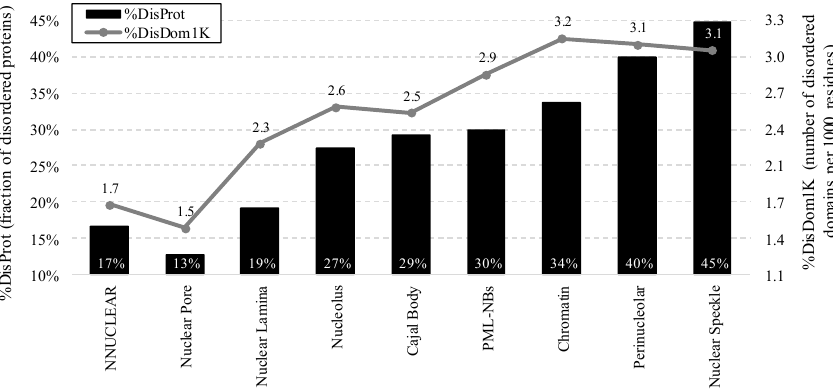
Figure 2. Fraction of disordered proteins (black bars) and normalized number of disordered domains (gray line) for the non-nuclear proteins from the NNUCLEAR dataset and proteins in the considered intra-nuclear compartment from the NUCLEAR ap dataset. Disorder was annotated with the consensus of Espritz and IUPred.